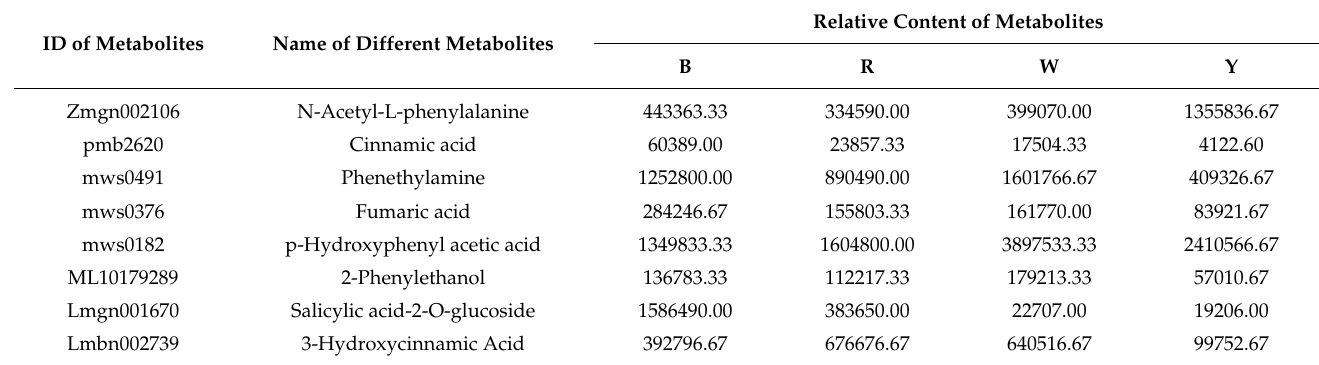
Table 4. Relative contents of different metabolites in grains of different cultivars of